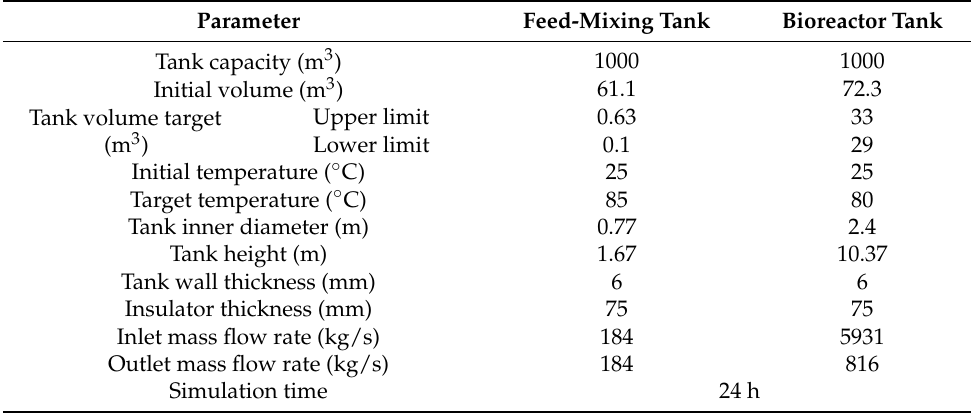
Table 3. Operating parameters of the feed-mixing and bioreactor tanks in the bio-integrated gasifica- tion combined cycle